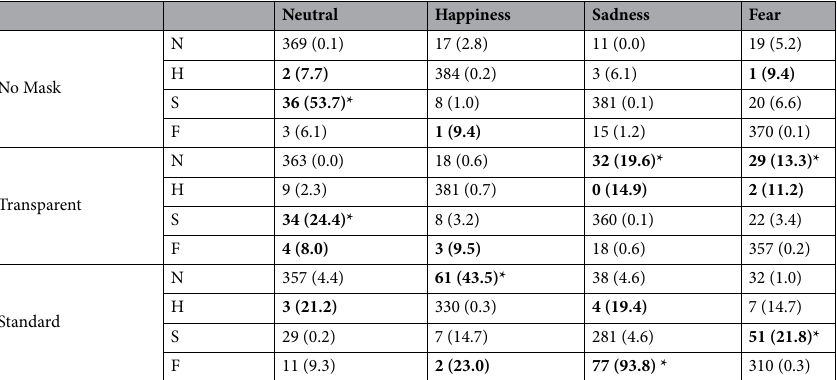
Table 2. The table indicates the direction of errors in the emotion categorization task. For each condition, columns indicate the presented emotions (n = 410 trials for NM and TM, and n = 400 trial for SM). Rows illustrate the responses given by participants, and the chi-square value calculated by comparing each cell with the corresponding expected value ( χ 2 in parentheses). Cells in bold indicate cells whose individual chi-square value exceeds the average value in that condition. Asterisks indicate the comparisons where the real value was significantly higher than the expected one.